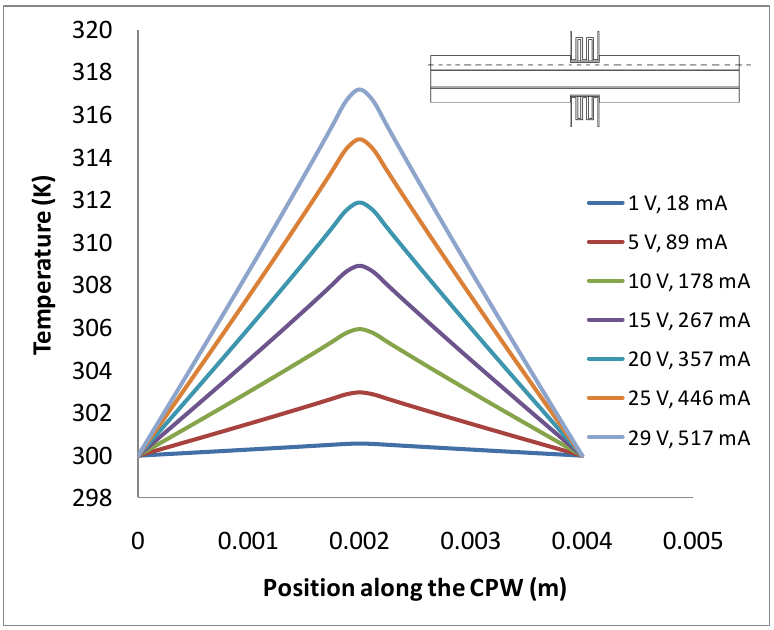
Figure 5. Temperature distribution in the ground line of